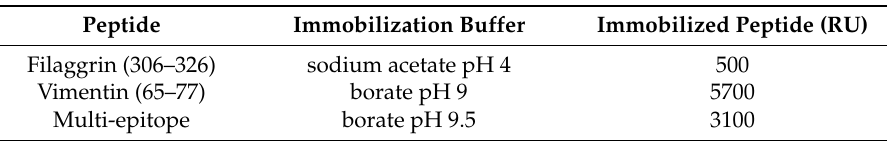
Table 3. Characteristics of peptide immobilization on GLH